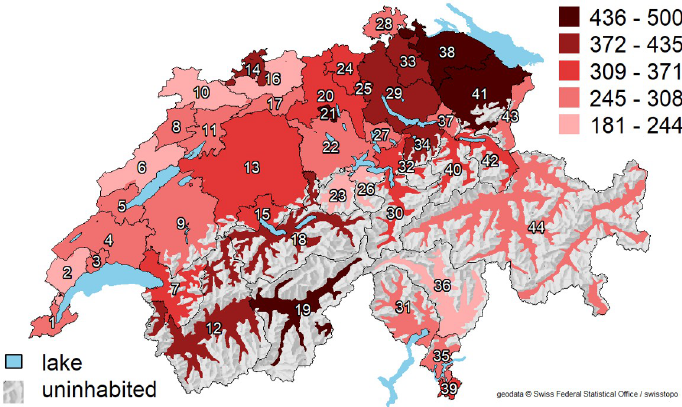
Fig 3. Map of the average adjusted predictions of prostate surgery rates across 44 Swiss Hospital Service Areas. Average predicted prostate surgery rates for each HSA are shown as red-scale categories per 100,000 men � 40 years of age. Adjusted for procedure year, age, language region, density of male population, mean Swiss Neighborhood Index of Socioeconomic Position, insurance status, Swiss citizenship, disease burden of the male population, density of urologists, and urologists’ time since graduation. Rate categories were chosen to be about equal in width. Shaded relief map reprinted from the Federal Office of Topography swisstopo, Switzerland https://shop.swisstopo.admin.ch/en/ products/maps/overview/relief and shape files derived from postcode-level shape file used to create map of Switzerland, e.g., https://www.geocat.admin.ch/) under a CC BY license, with permission from Alexandra Frank, original copyright